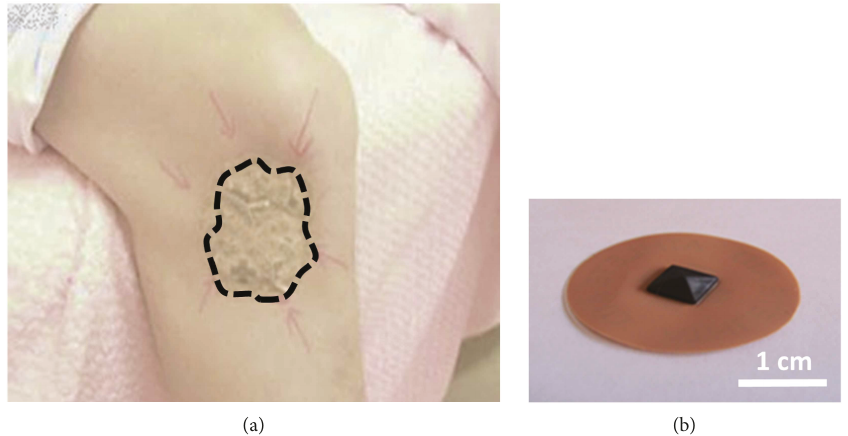
Figure 1: Pyramidal thorn patch treatment. (a) Several pyramidal thorn patches are applied at the pain region. The pain region moves like a “ cutaneous rabbit ” toward the spinal cord. (b) Patch with silicon pyramidal thorn. Diameter is 3